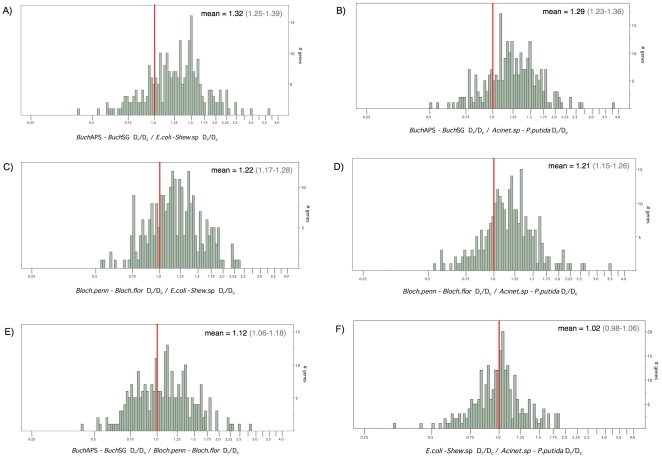
Empirical data: Frequency distributions of the ratio of two Dr/Dc values illustrate elevated values in endosymbionts compared to free-living bacteria.The ratio of two Dr/Dc values (or, the ‘elevation index’ described in the text) is presented along the x-axis on a log scale for ease of comparison. Mean values and 99% confidence intervals are listed for each comparison. Equality of the two Dr/Dc values would give a ratio of one, indicated by the red reference line. (a–d) Dr/Dc is substantially elevated within Buchnera and Blochmannia when either is compared to related free-living bacteria. Considered in the framework of this figure, significant sign test results for these comparisons (Table 6) indicate that significantly more genes fall above the value of one (i.e., higher Dr/Dc in endosymbionts) than fall below this value. Differences were modest between (e) Buchnera and Blochmannia and (f) free-living bacterial pairs. Dr/Dc was calculated under the classification scheme of Miyata et al. [56].